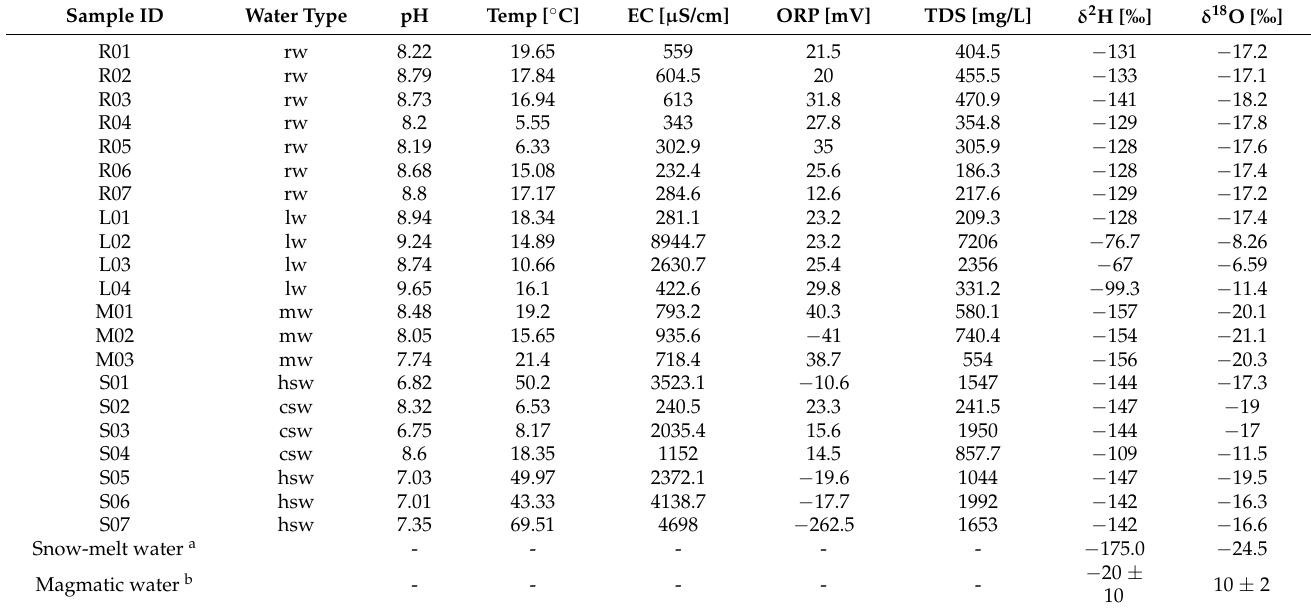
Table 1. Physical parameters and hydrogen and oxygen isotopes of water samples from the Zhaxikang groundwater system.